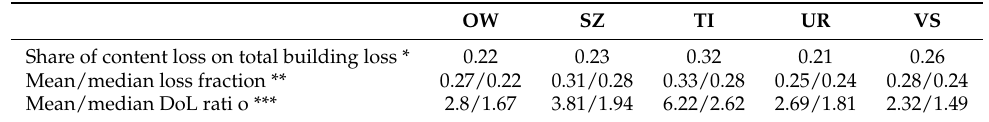
Table 1. The role of household contents in five Swiss Cantons. OW: Obwalden, SZ: Schwyz, TI: Ticino, UR: Uri, VS: Valais. * Share of the summed content loss on the summed total (structure + content) loss per canton. ** Means and medians of observed shares of content loss on total loss. *** Means and medians of the observed ratios of degrees of loss of contents to degrees of loss of structure OW SZ TI UR VS Share of content loss on total building loss